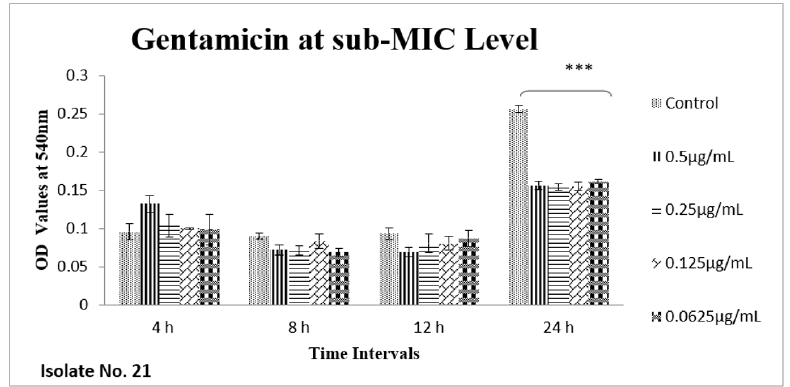
Figure 2. Bar graph shows the effects of gentamicin on E. coli biofilms (OD 540 nm). Overall significant reduction (*** p value < 0.001) in biofilm formation was observed after 24 h in comparison to the control samples.